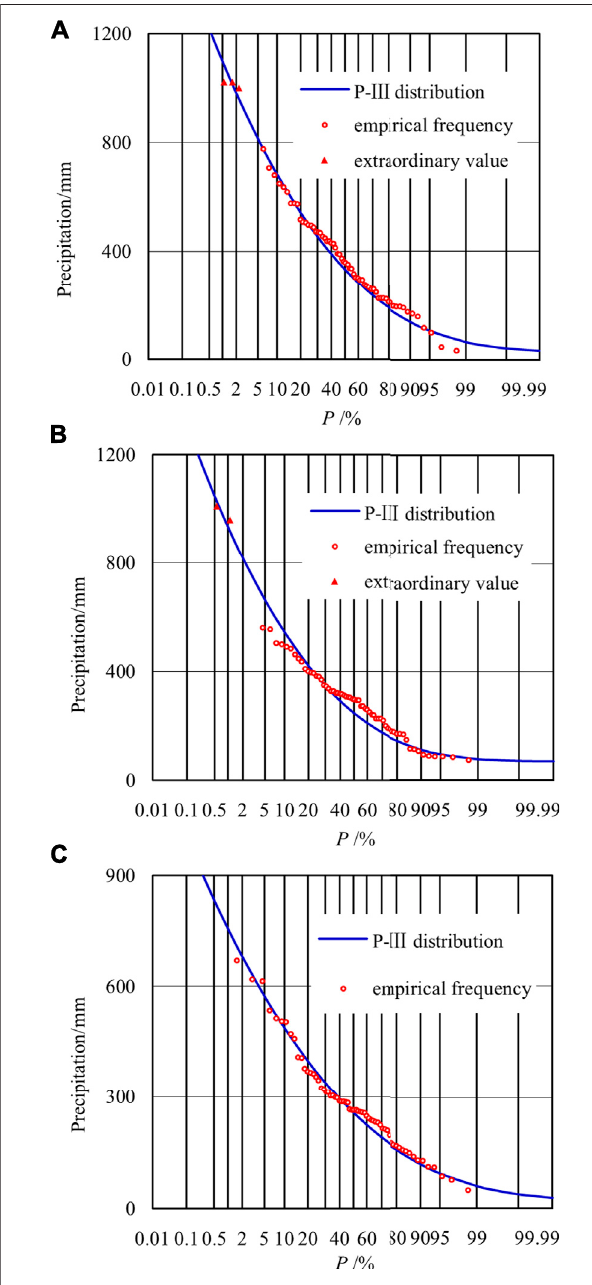
FIGURE 2 | Frequency curve of precipitation during Meiyu and Huang- Huai rainy seasons from 1957 to 2020 in (A) SYA, (B) YHA, and (C) NHA.